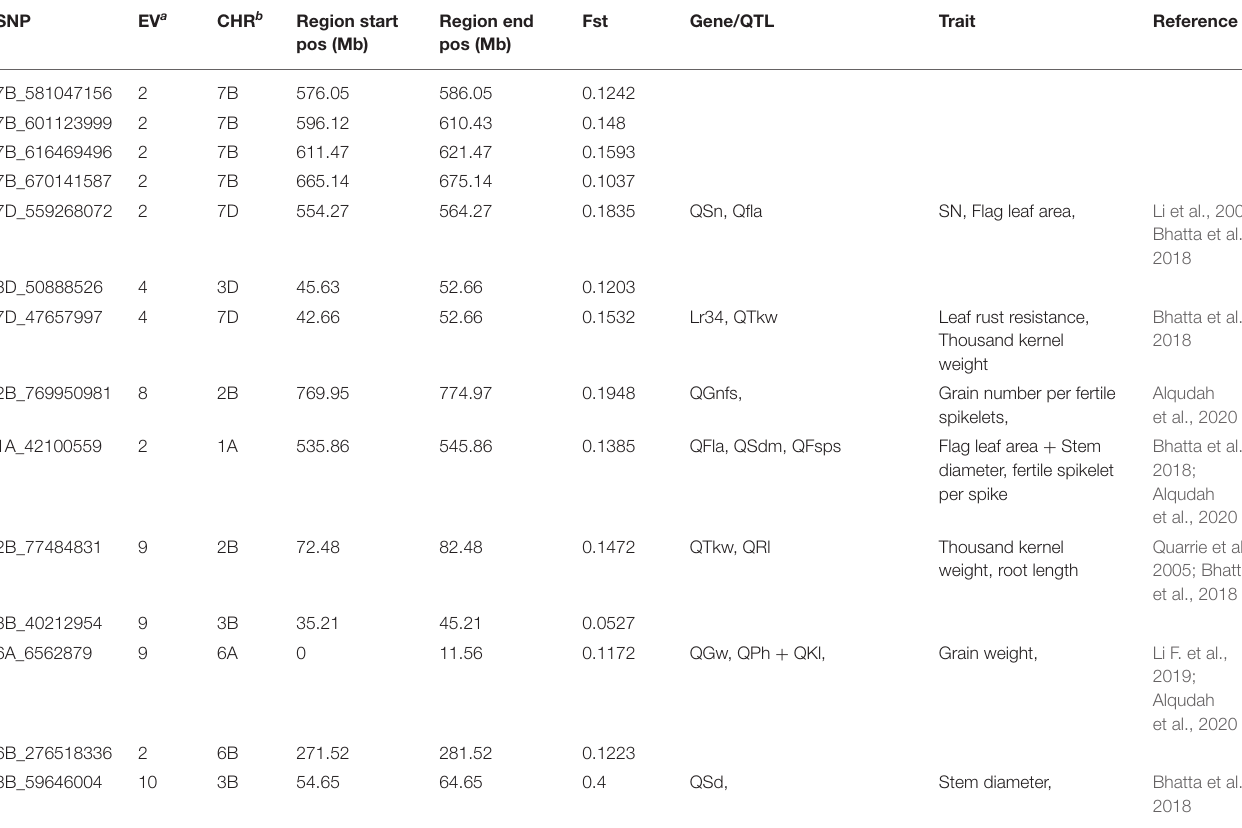
( Figure 6 ). Of the whole-genome GBS-SNPs, over